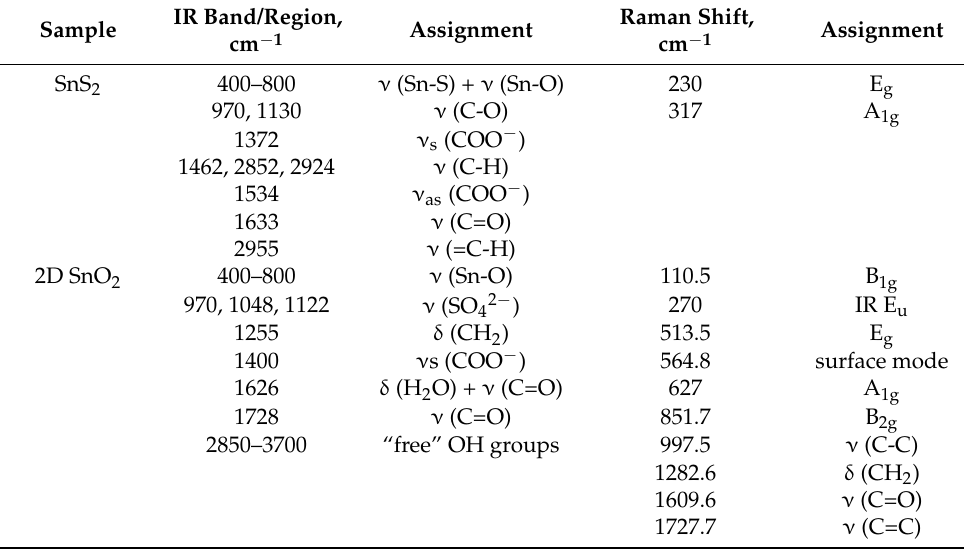
Table 1. Assignments of IR bands and Raman vibrational modes (cm − 1 ).